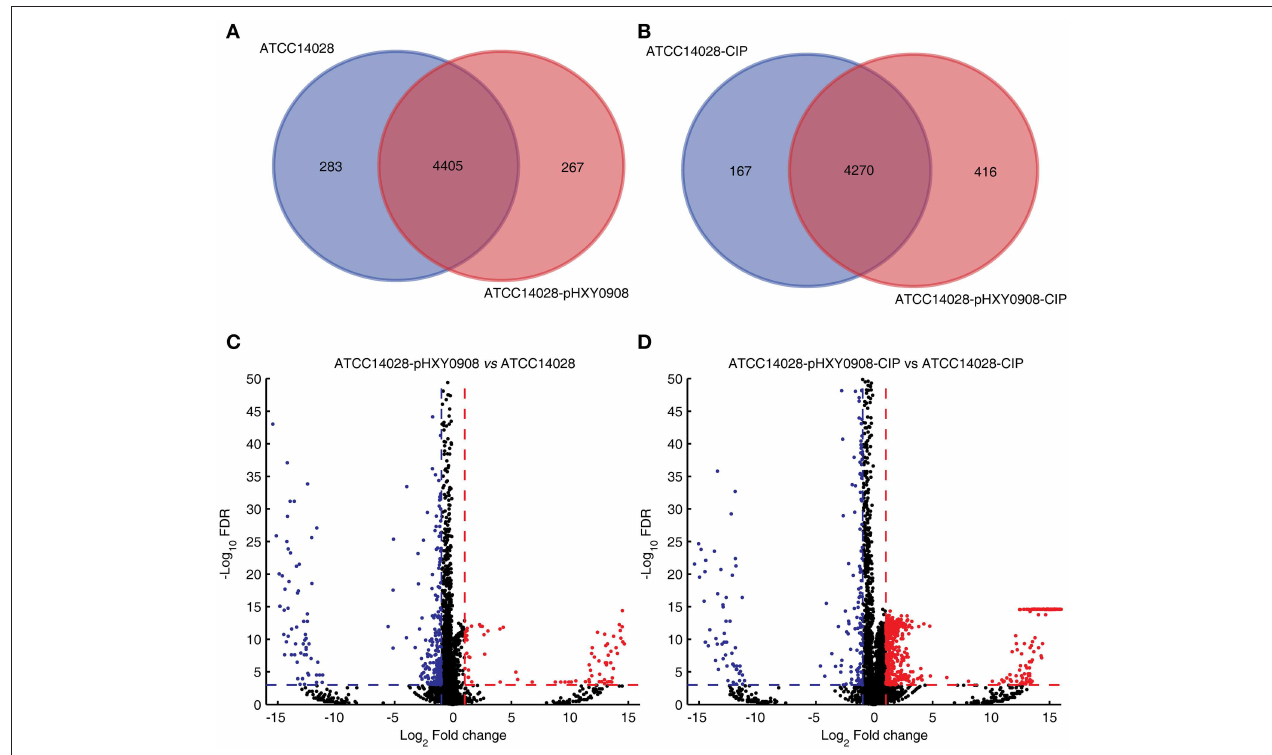
FIGURE 3 | Venn diagram of expressed genes and volcano plot. (A) Venn diagram of expressed genes in ATCC14028 and ATCC14028-pHXY0908. (B) Venn diagram of expressed genes in ATCC14028-CIP and ATCC14028-pHXY0908-CIP. (C) Volcano plot of ATCC14028-pHXY0908 vs. ATCC14028. (D) Volcano plot of ATCC14028-pHXY0908-CIP vs. ATCC14028-CIP. The blue plot in volcano plot represented down-regulated genes (Log 2 Fold change ≤ − 1 and FDR < 0.001). The red plot in volcano plot represented up-regulated genes (Log 2 Fold change ≥ 1 and FDR <